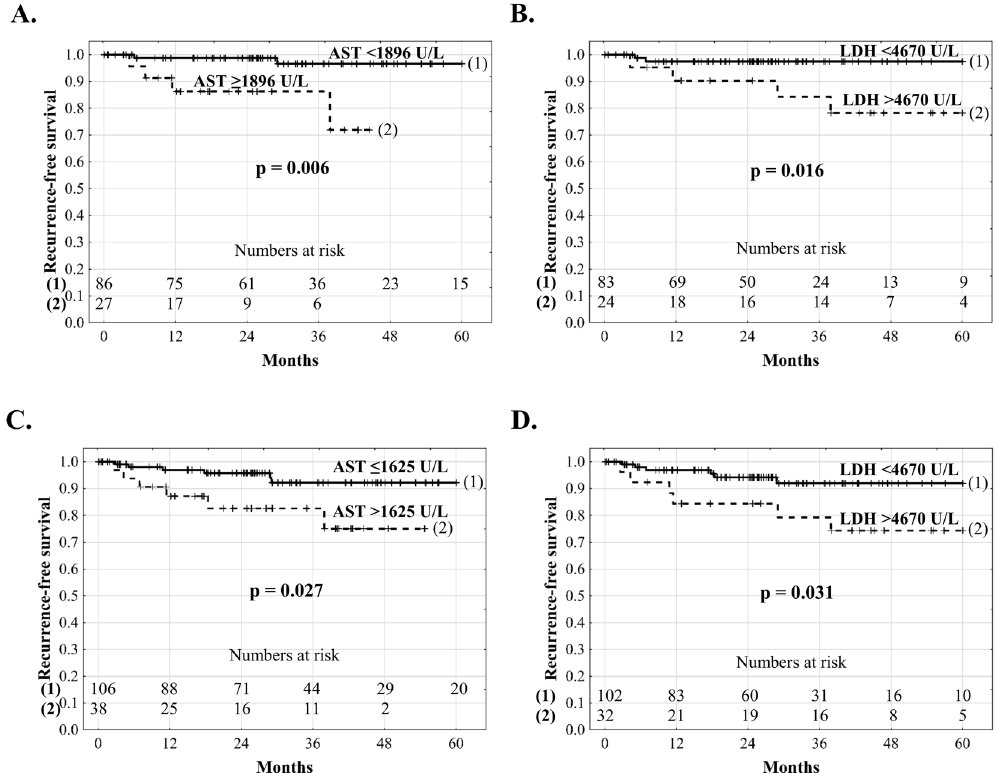
Figure 3. Recurrence-free survival after liver transplantation for hepatocellular carcinoma in patients within Milan criteria ( A , B ) and Up-to-7 criteria ( C , D ) according to post-reperfusion aspartate transaminase and lactate dehydrogenase